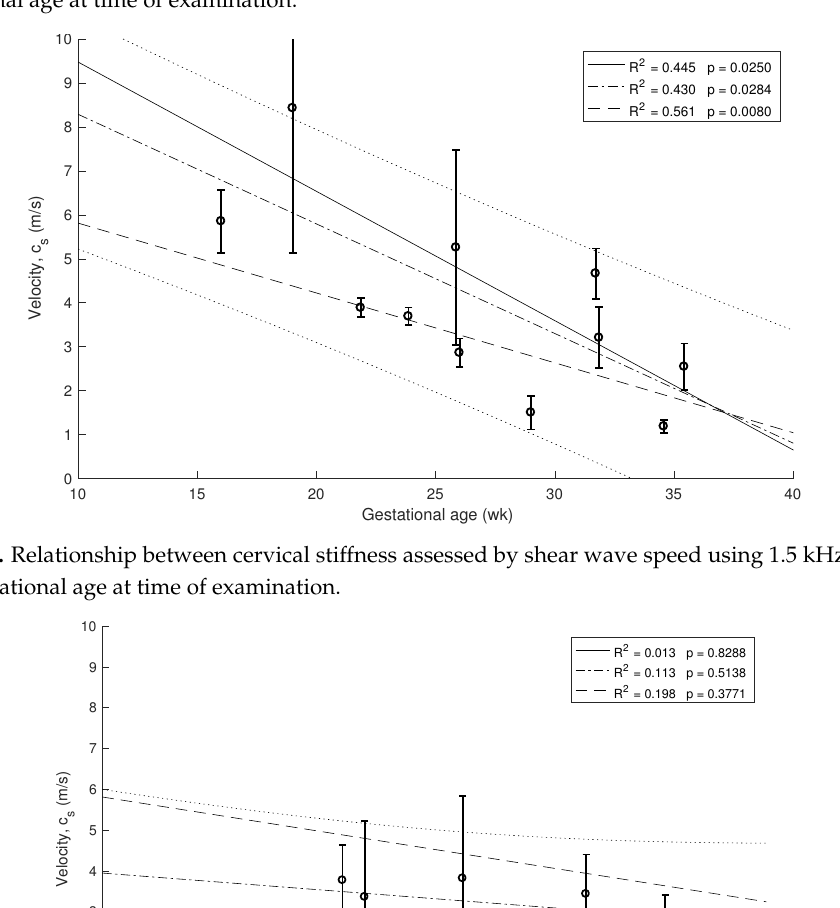
Figure 5. Relationship between cervical stiffness assessed by shear wave speed using 1 kHz waves and gestational age at time of examination.